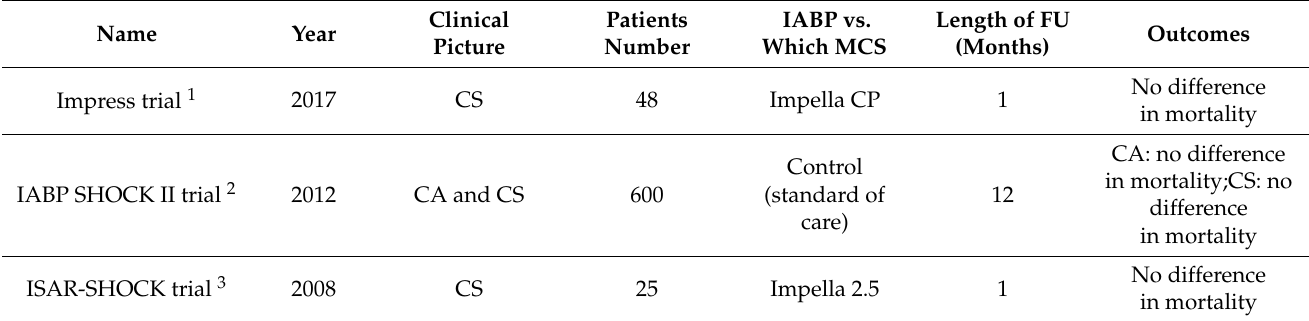
Table 1. Summary of the